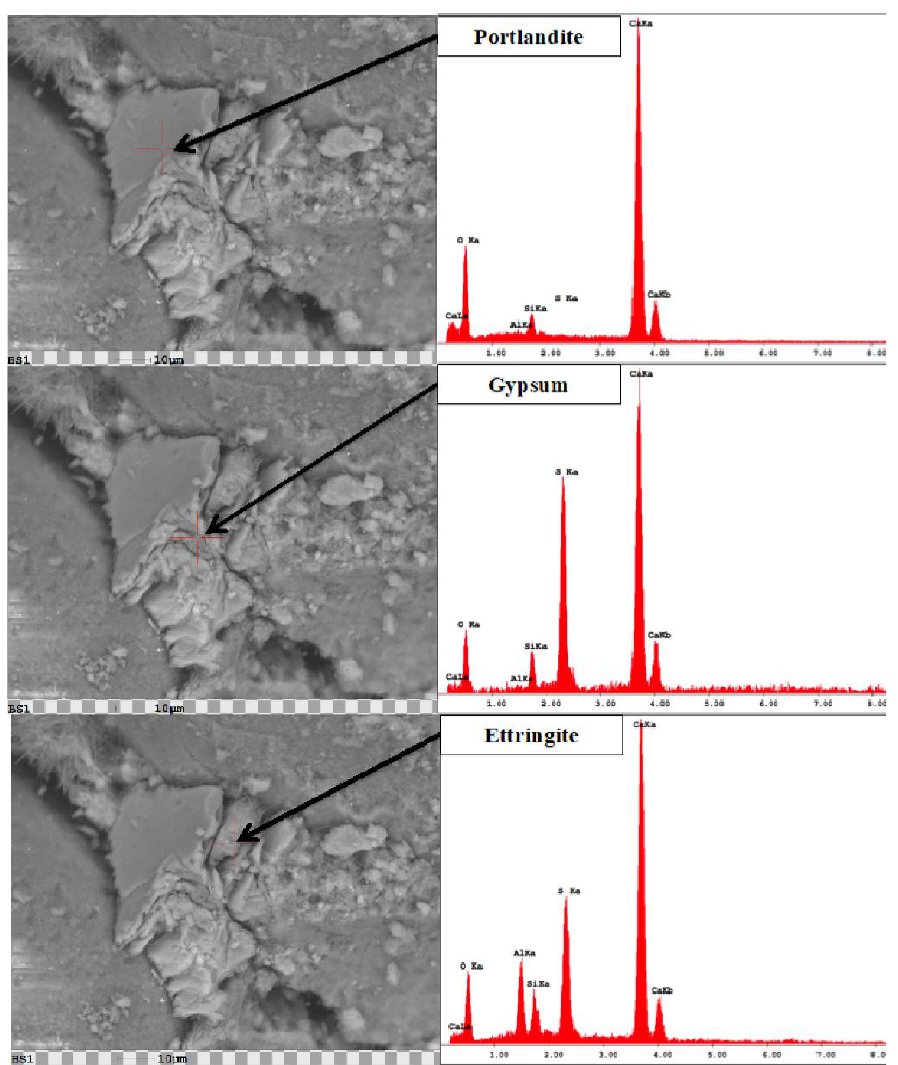
Figure 7. SEM images coupled with EDS showing C1-30HC mixture after 4 months exposure in 0.89% Na 2 SO 4 .